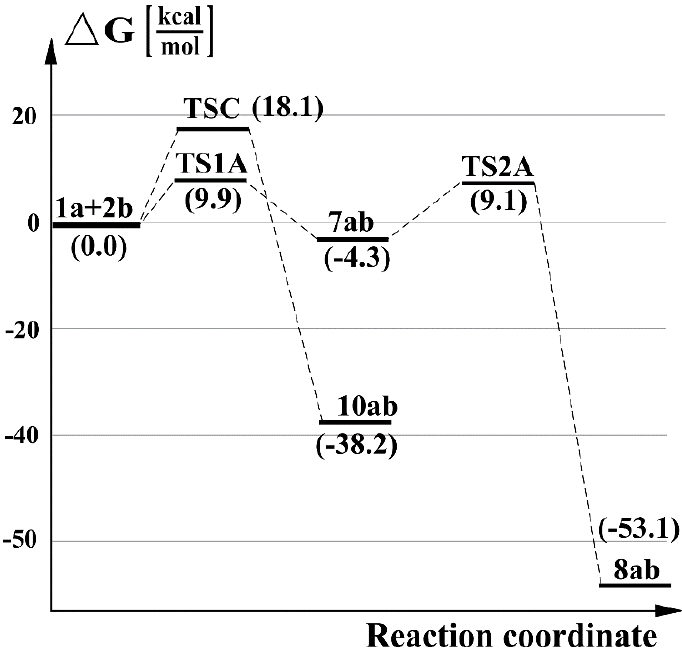
Figure 6. Gibbs free energy profile for reaction of dichlorocarbene ( 1a ) with 3-thioxo-2,2,4,4-tetra- methylcyclobutanone ( 2b ) with in the light of wb97xd/6-311g(d,p)(PCM) computational study. Consequently, from a kinetic point of view, within the analyzed reaction system, the addition of 1a to the >C=O moiety, leading to an intermediate carbonyl ylide, should be considered as a forbidden process. From a mechanistic point of view, thus, the reaction leading to 2,2-dichlorooxirane derivative 10ab , proceeds via a completely different scheme as in the case of thiirane formation. In particular, the addition occurs via single transition state. Within this TS, two new ϭ bonds are formed simultaneously and formally,